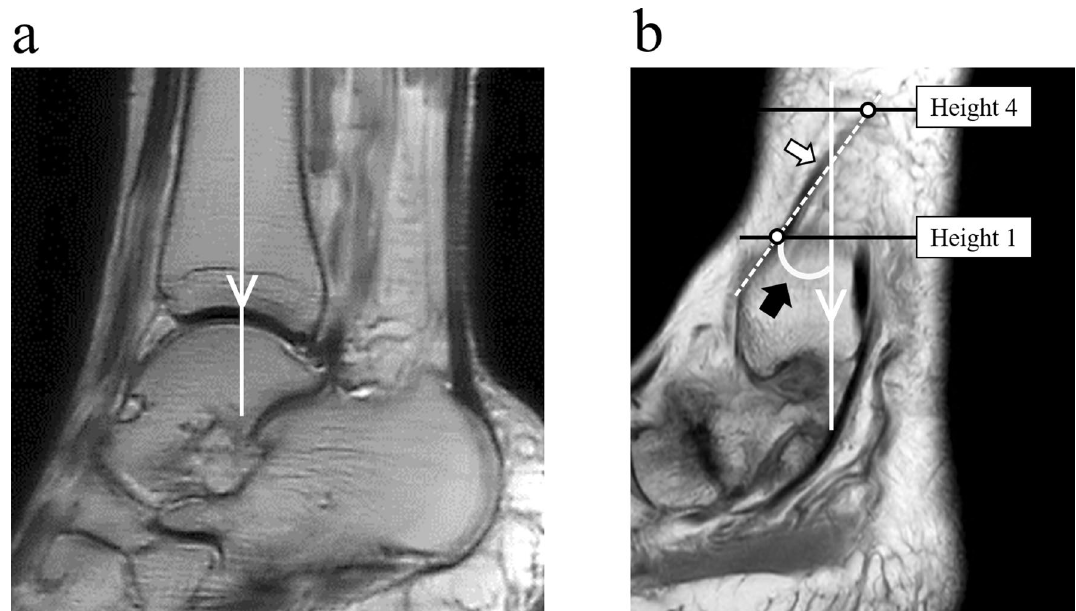
Figure 3. Sagittal images of the ankle joint based on the tibia. ( a ) The tibial axis is indicated. ( b ) The course of the great saphenous vein is indicated from height one to height four, and the angle formed between this line and the tibial axis is observed. White arrow: Great saphenous vein. Black arrow: Angle of the course of the great saphenous